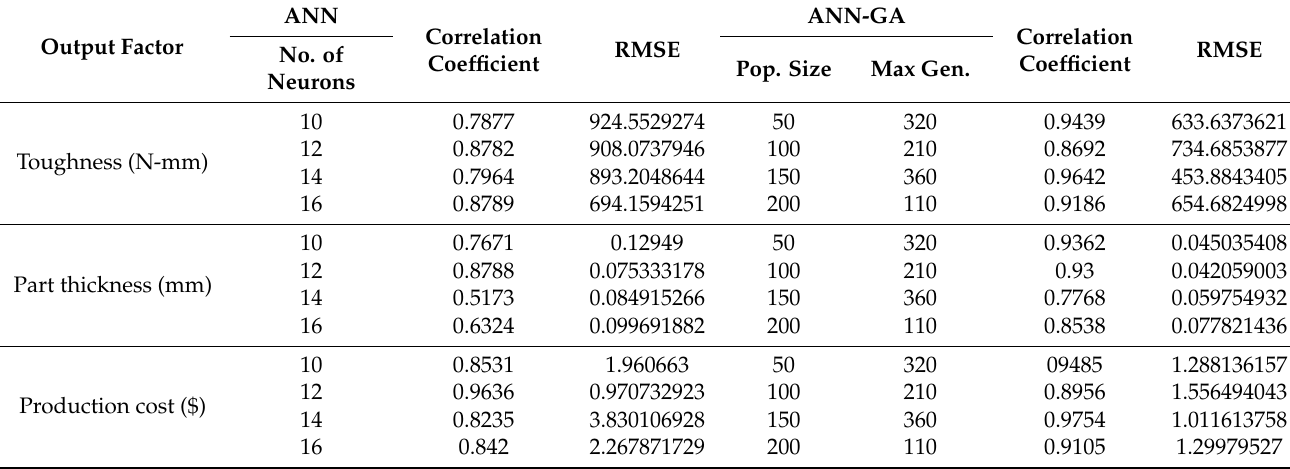
Table 9. Results for the training phase.